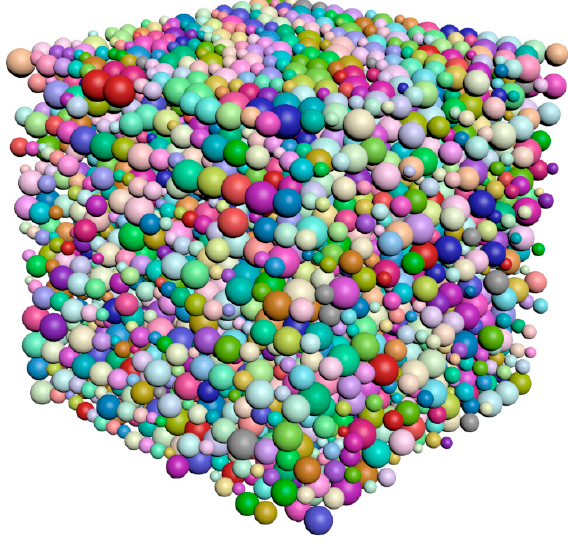
Figure 3. Results of compactness algorithm execution.